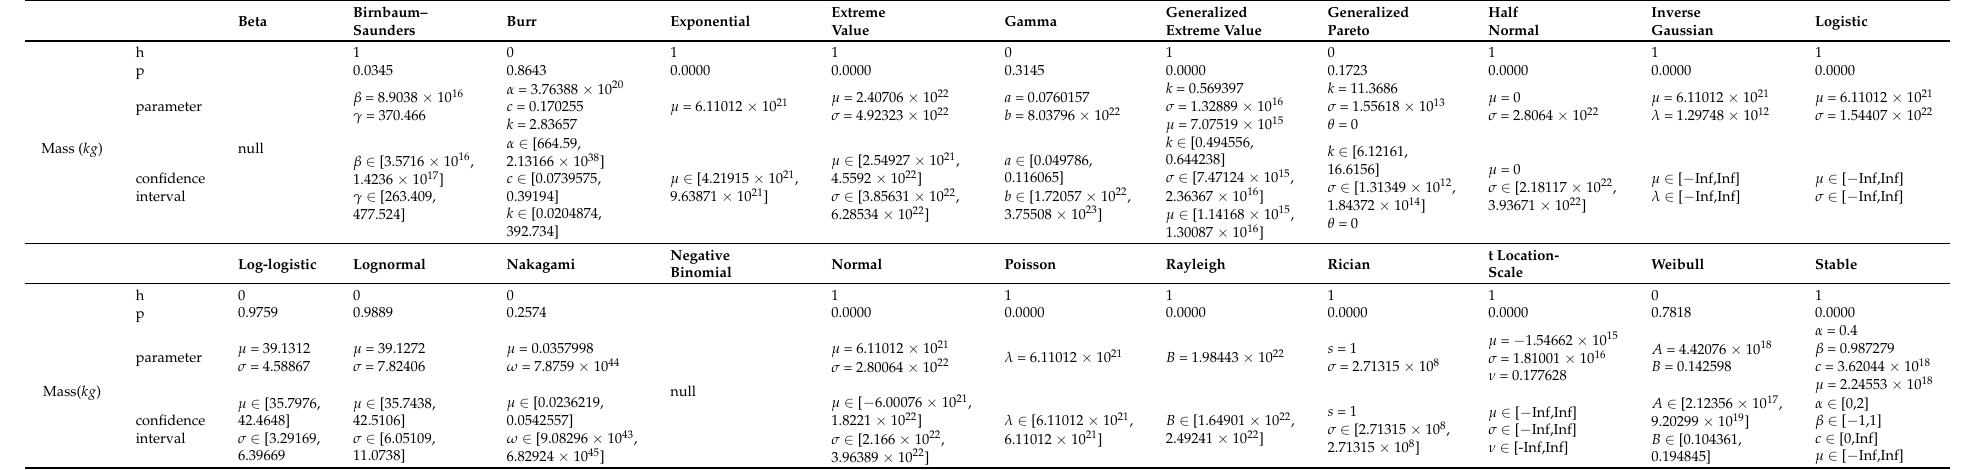
Table 2. Statistical inference results of the mass of Saturn’s regular